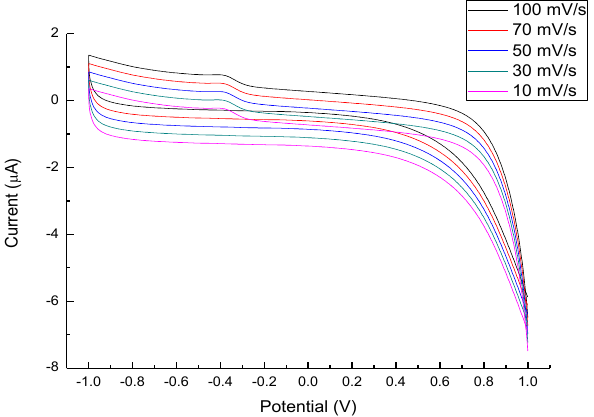
Figure 8. CV profiles under different scan rates in 1 M NaOH (aq) solution and 1 mM glucose.